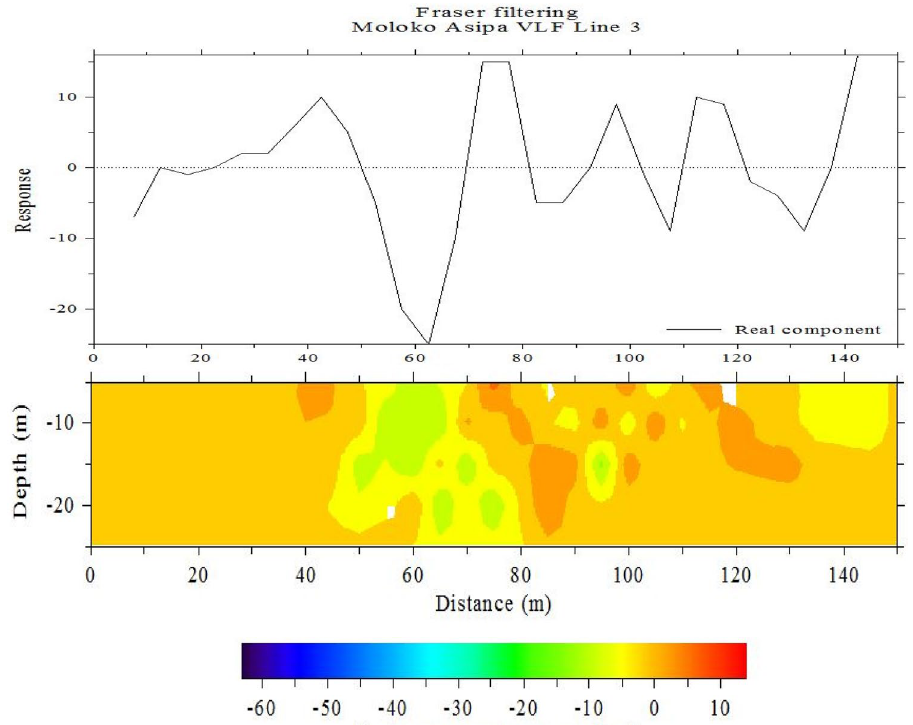
Fig. 4 Fraser and Karous–Hjelt representation for traverse